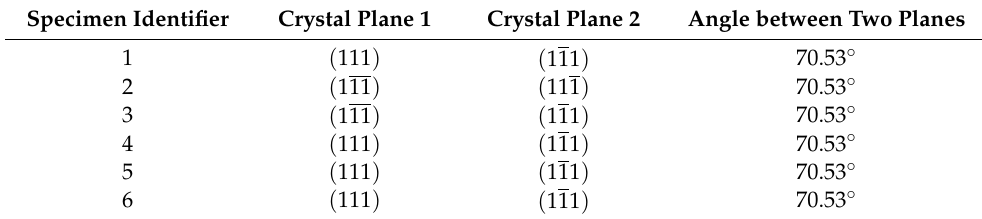
Table 2. Distribution of crystal planes in the fractured microstructures.